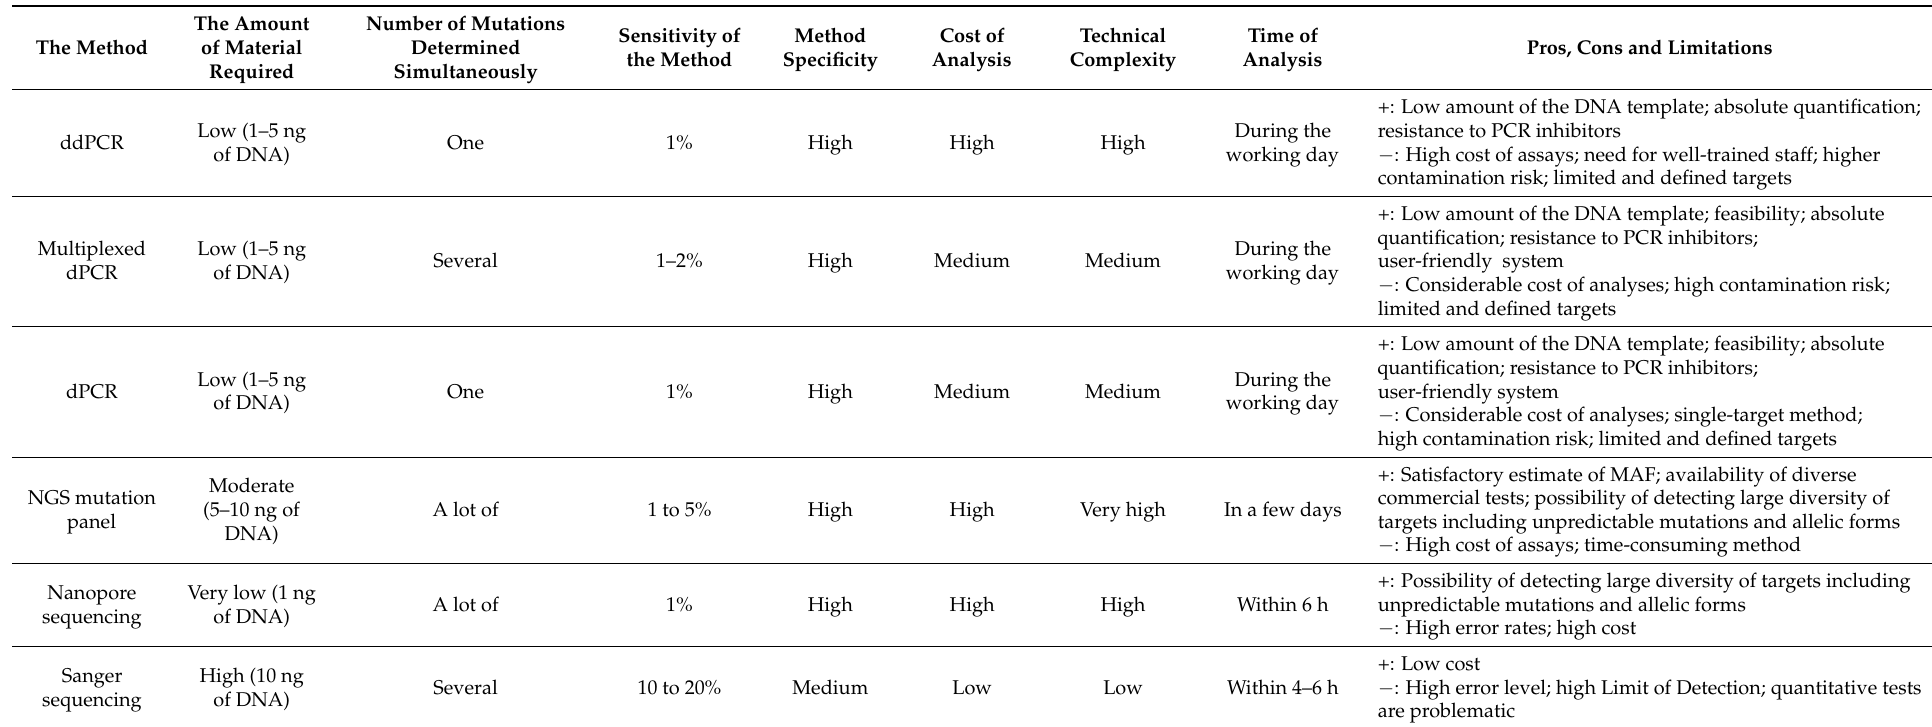
Table 4. Comparison of characteristics of methods for determining TERTp